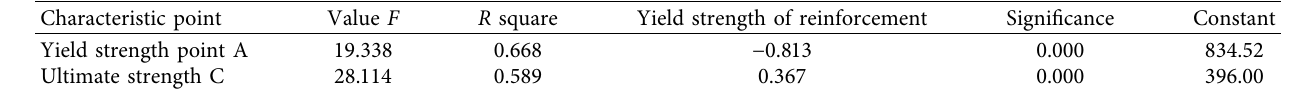
Table 4: The stress fitting results of the characteristic points.